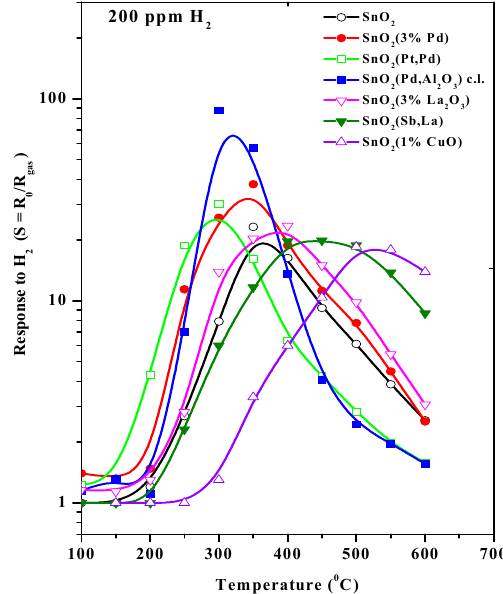
Figure 7. Response of the sensor based on SnO 2 with different decorations to 200 ppm of H 2 as a function of sensor temperature. Reprinted with permission from author [27].